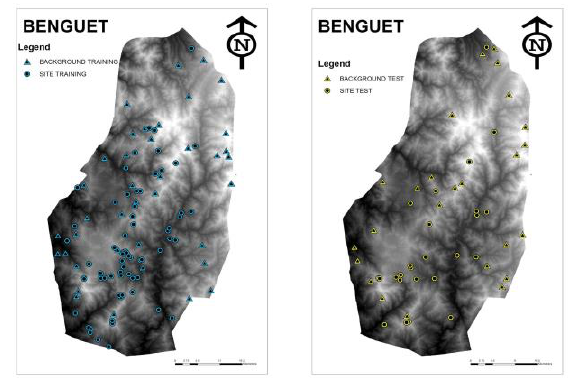
Figure 3. Location of points for developing the landslides susceptibility model (left) and for validating the model (right). The sets of points consist of locations where landslides occurred (site) and where landslides did not occur